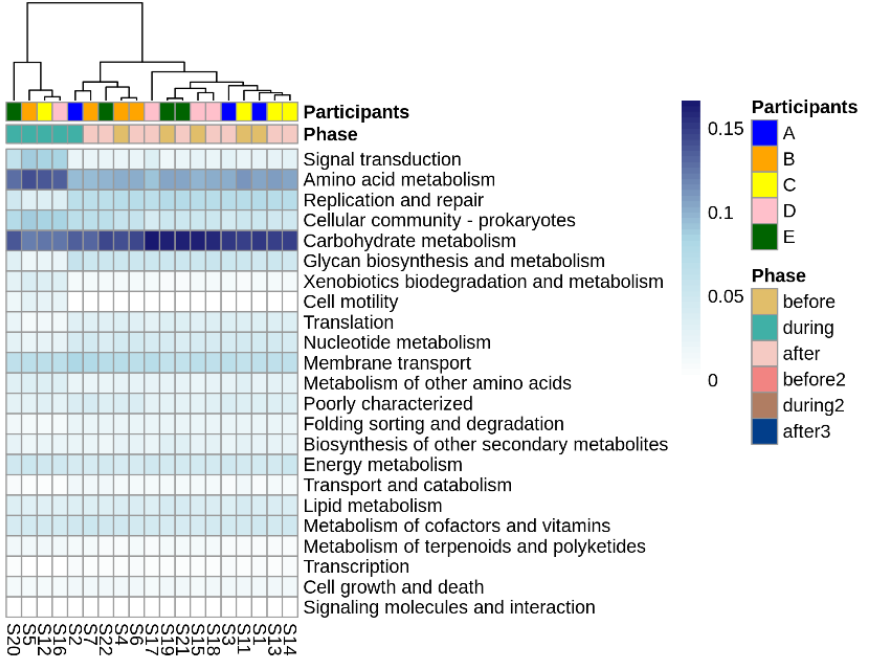
Figure 6. Differentially abundant Tier 2 KEGG pathways before, during, and after disruptive norovirus-associated AGE. The first-row color scale indicates the patient numbers. The second row shows the phase of sample collection; before, during, or after AGE. Numbers following “S” indicate the sample identifier for metagenomic data. Note that for Participant A and for the second norovirus infection of Participant B, the during infection microbiomes are grouped with the ‘before’ and ‘after’ infection the microbiomes of all children, including their own.